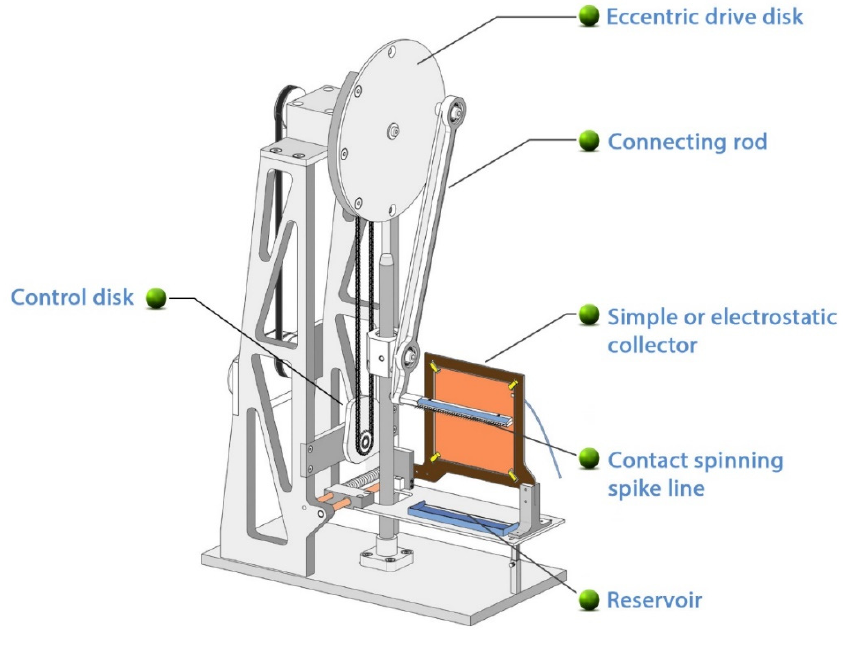
Figure 1. Three-dimensional view of contact drawing device.